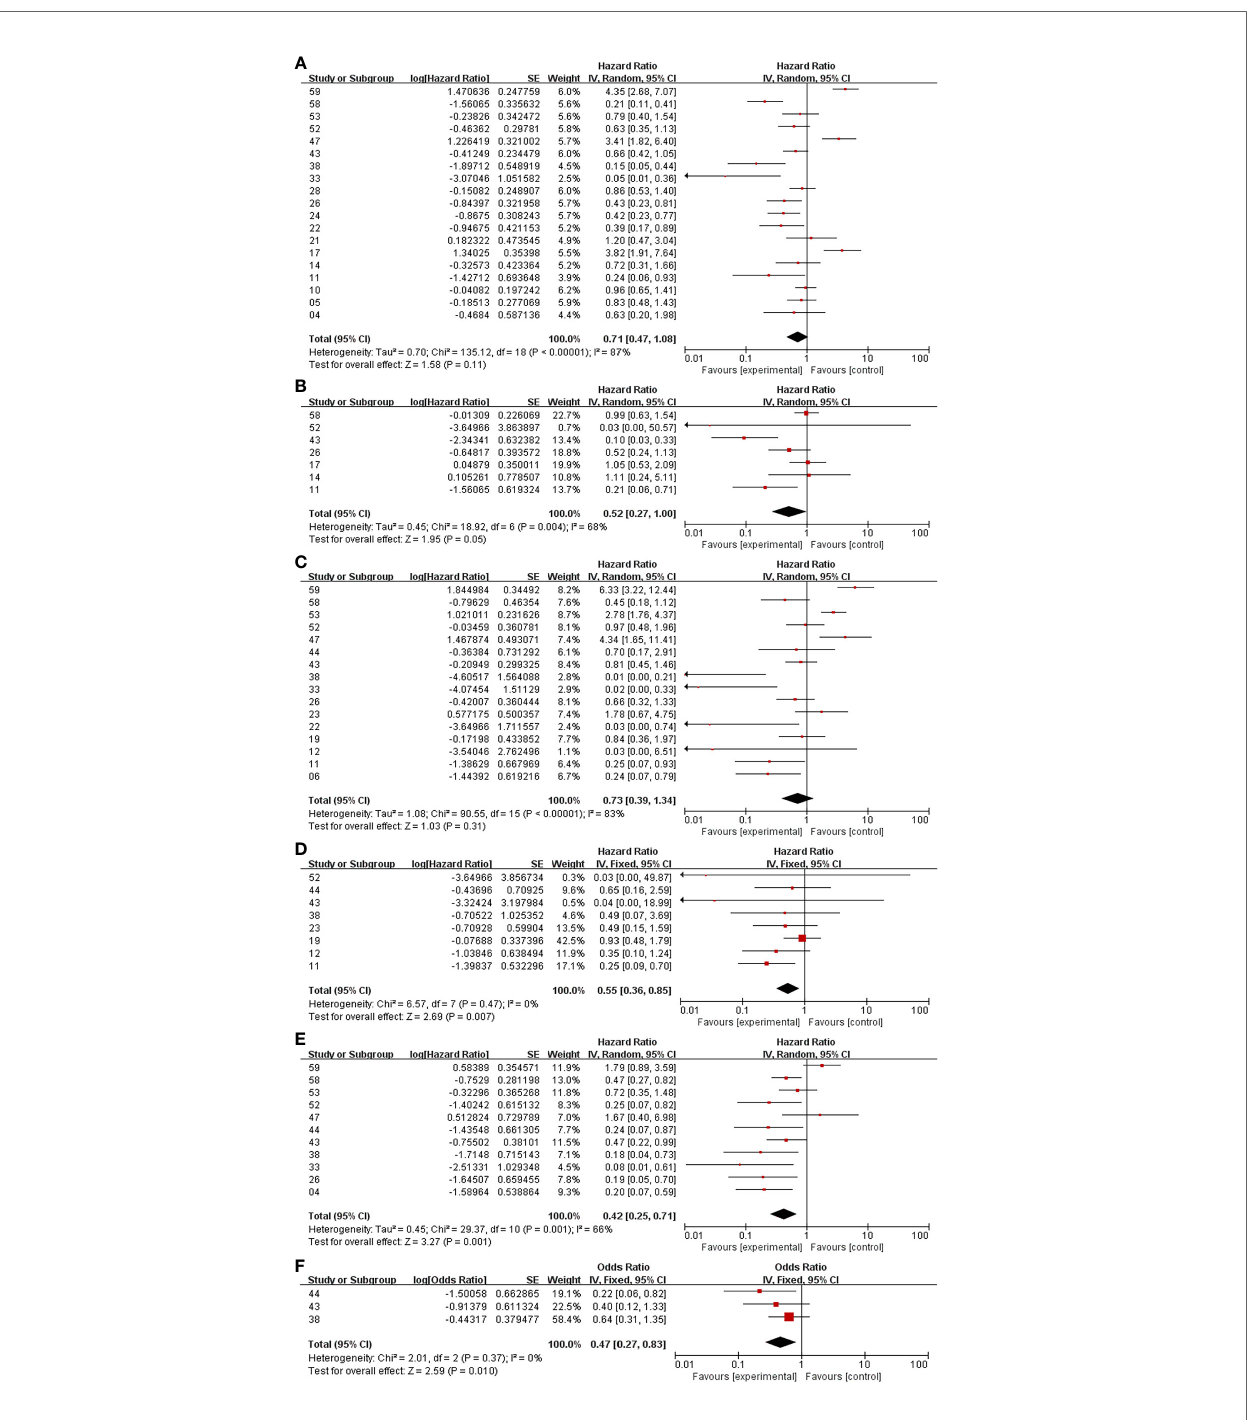
FIGURE 2 | Meta-analysis. Surgery+RT vs Surgery, PFS (A) . Surgery+RT vs Surgery, OS (B) . GTR+RT vs GTR, PFS (C) . GTR+RT vs GTR, OS (D) . STR+RT vs STR, PFS (E) . STR+RT vs STR, OS (F)